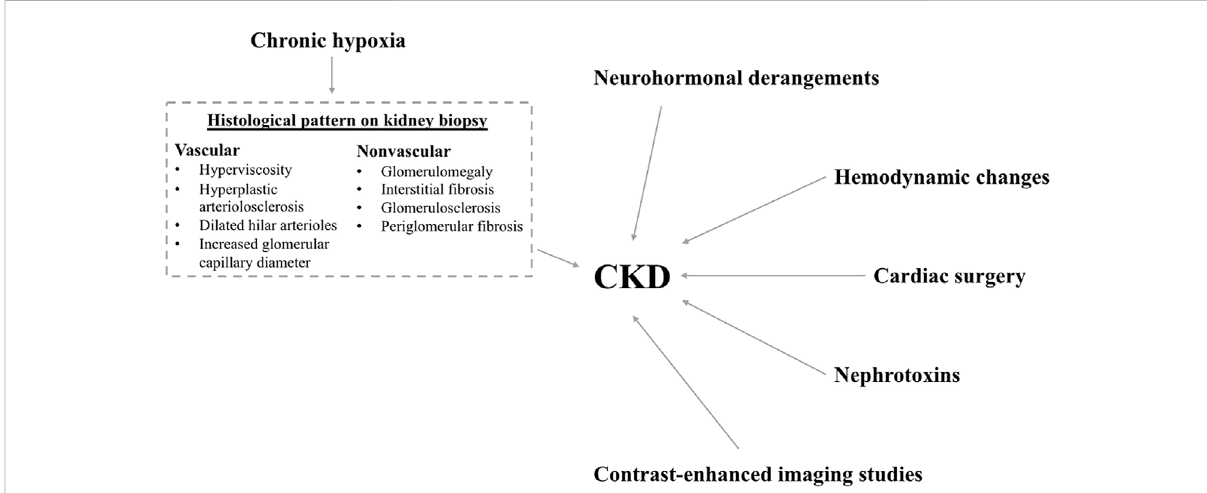
FIGURE 1 Factorsleadingto chronickidneydisease. Figurelegend: Schematic diagramshowingthemultipleriskfactors forCKDdevelopment.Theserisk factors include: neurohormonal derangements, hemodynamic changes, cardiac surgery, nephrotoxins, contrast-enhanced imaging studies and chronichypoxia.Thehistologicalchangesseenonkidneybiopsyofpatientswithchronichypoxiaincludevascularandnonvascularchangesaslisted in the dashed text